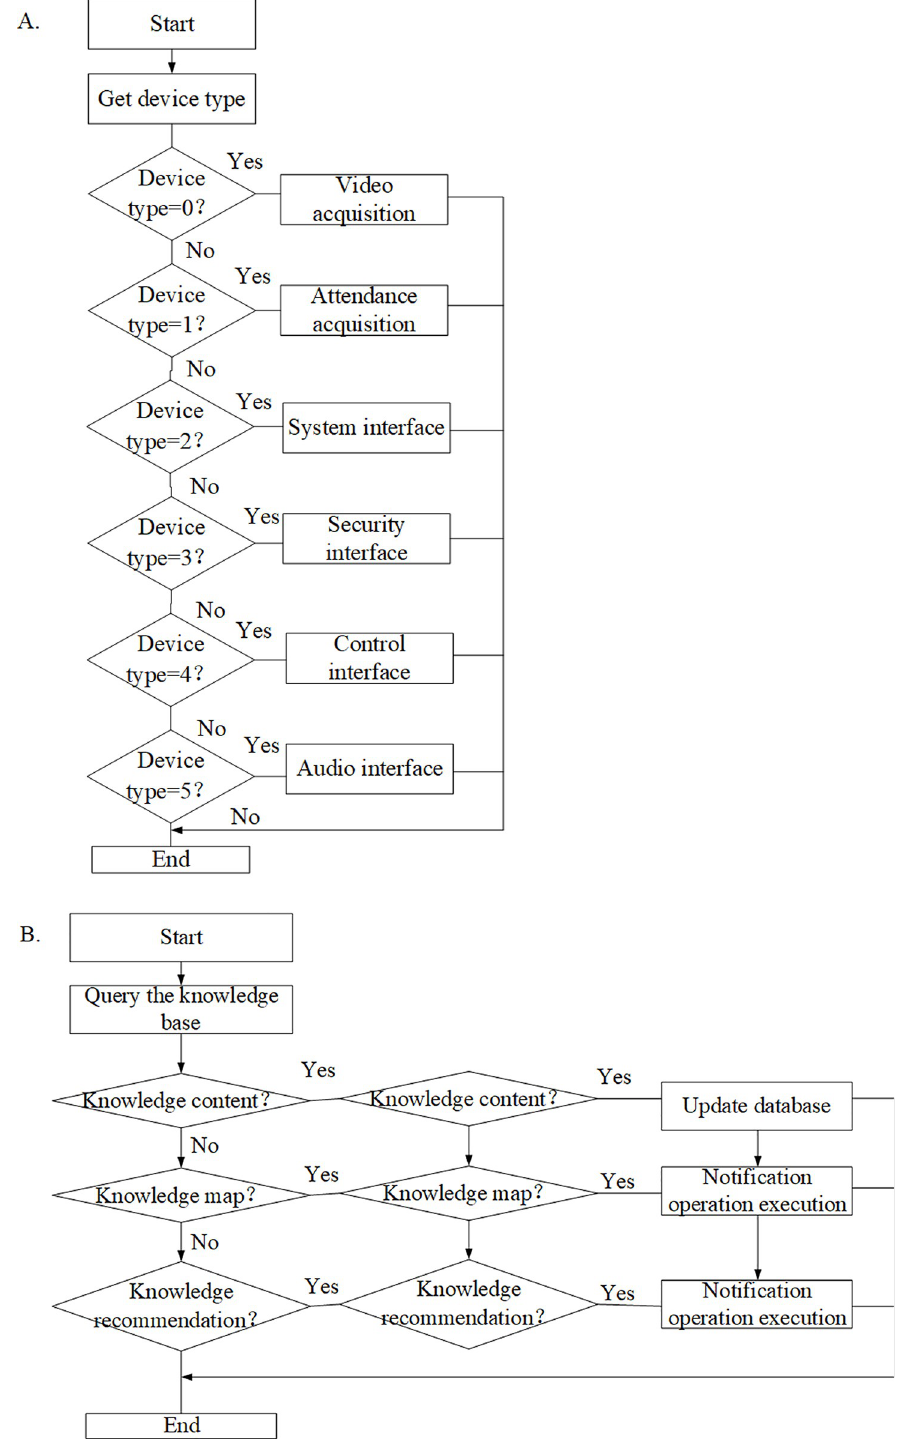
Fig 10. Flow chart of equipment list and knowledge management